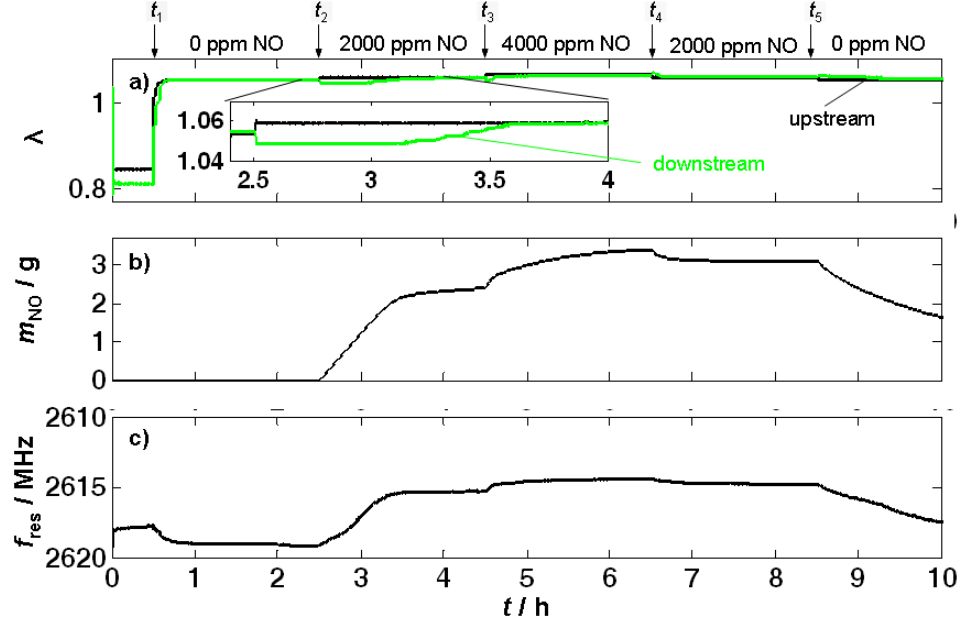
loading experiment of an LNT monitored by the microwave-based Figure 3. NO x technique at 300 °C. Time responses of (a) the normalized air-to-fuel ratio λ upstream and downstream of the catalyst, (b) the NO loading as calculated by Equation (4) and (c) the x resonance frequency f res